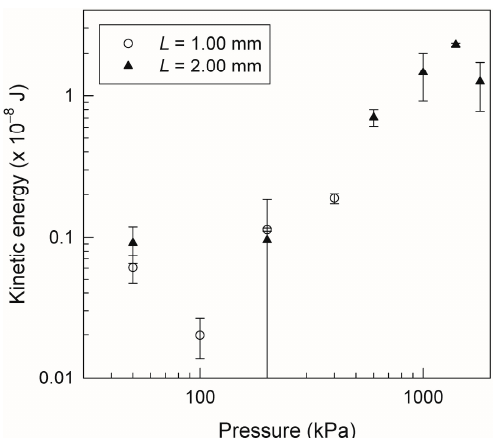
Figure 5. Kinetic energy of the droplet as function of applied pressure in microchannels of L = 1.00 mm and L = 2.00 mm. Error bars are calculated by propagating the standard deviations for the droplet velocity and length.